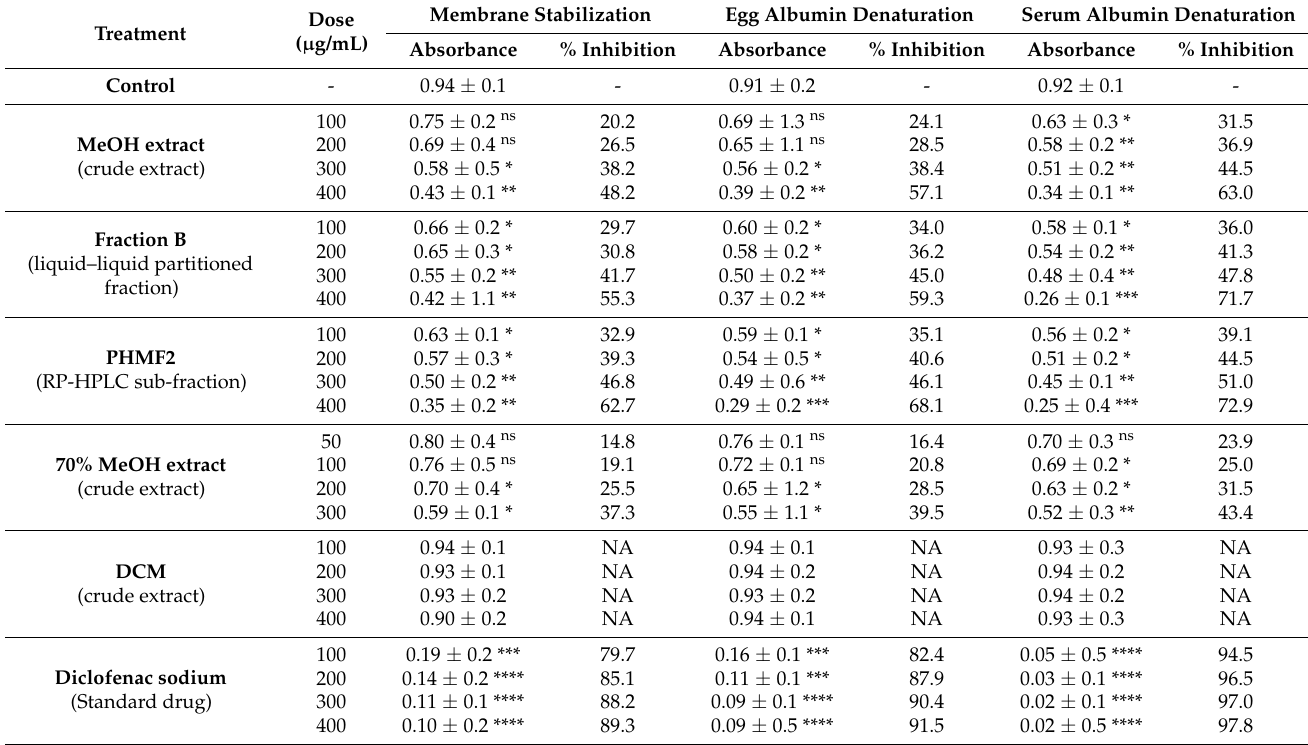
Table 2. In vitro anti-inflammatory activity of Peganum harmala crude extracts and subsequent fractions. Membrane Stabilization Egg Albumin Denaturation Serum Albumin Denaturation Dose Treatment ( µ g/mL) Absorbance % Inhibition